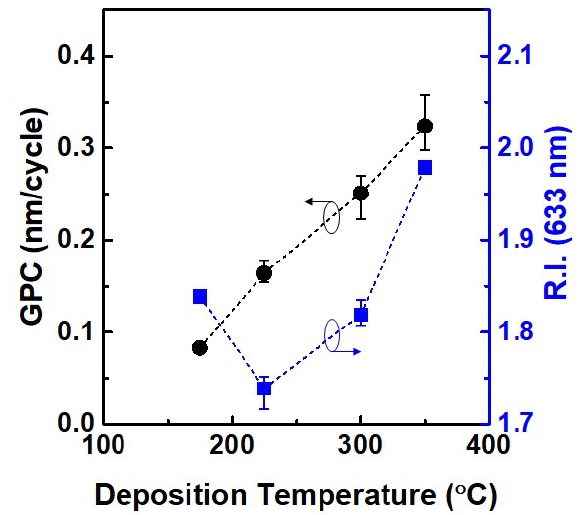
Figure 4. Growth-per-cycle (GPC) of AlN thin films as a function of the deposition temperature and refractive index (R.I.) at the wavelength of 644 nm with different deposition temperatures for trimethylaluminum (TMA) and hydrazine (N 2 H 4 ) precursors.